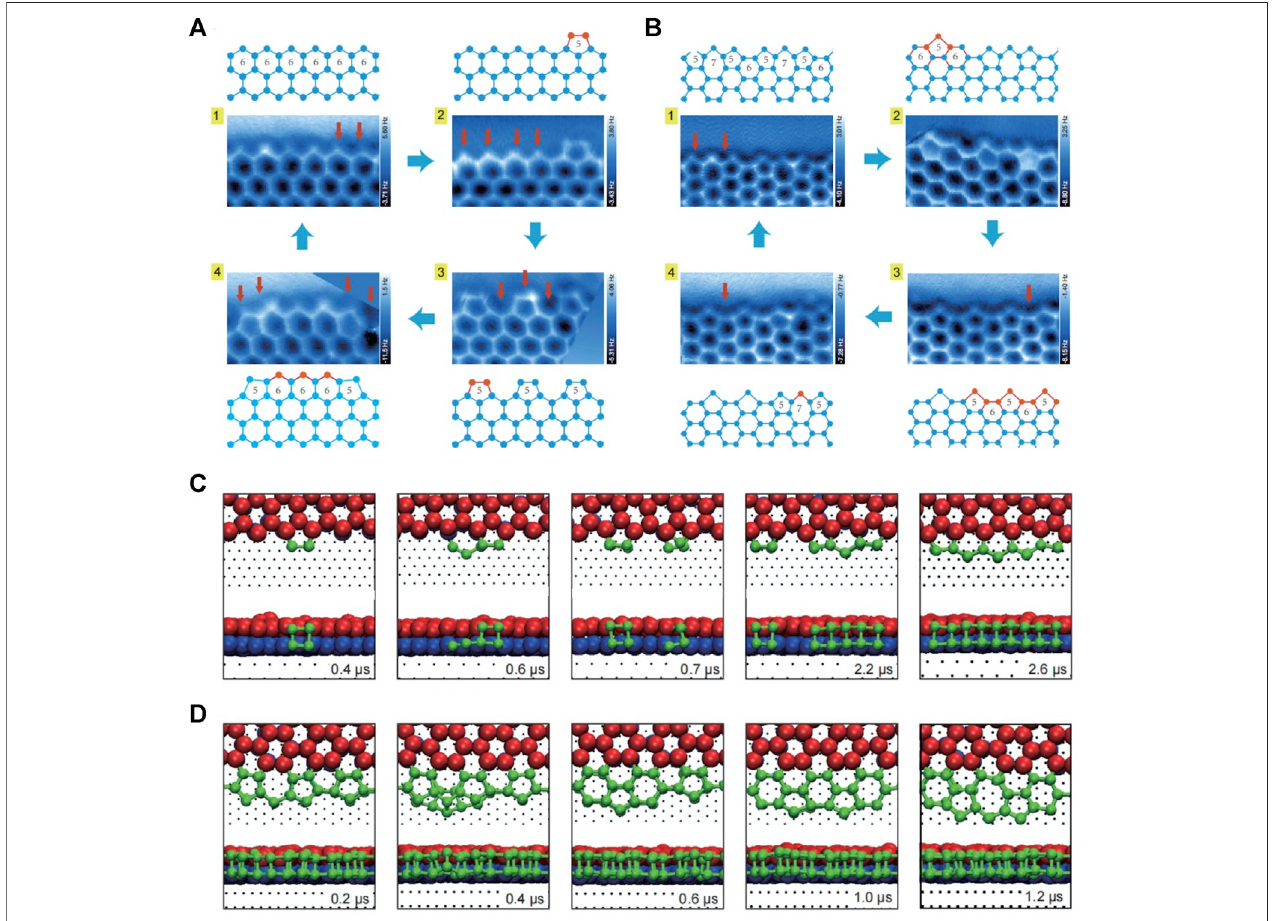
FIGURE 2 | The growth process of zigzag and armchair edges of the 2D bilayer hexagonal ice formed on Au(111) (A – B) Constant-height AFM images and corresponding models of the steady state (1) and metastable states (2 – 4) of the zigzag (A) and armchair edges (B) (C – D) Time-elapsed snapshots during the growth of zigzag (C) and armchair edges (D) obtained by MD simulation. In (A – B) , the proposed growing process (from one to 4) is indicated by blue arrows; the addition of one bilayer waterpair islabeled byared arrow in AFM images; the red ballsand sticks inball-stick models representthe newly added bilayer water pairs, while theblue ones represent the existing structures. In (C – D) , the simulation times are shown on bottom right of each snapshot, the bottom- and top-layer water molecules of the preexistent bilayer ice are denoted by the blue and red spheres, respectively; the newly deposited water molecules are denoted by the green spheres. Adapted with permission from Ma, et al . 2020. Nature 577(7788): 60 – 63 (Ma et al.,